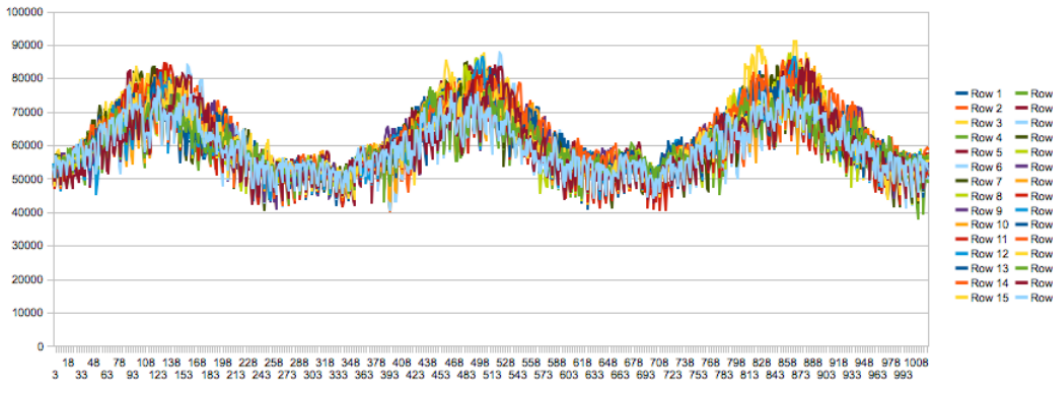
Figure 1. Demand profiles for the 30 stochastic scenarios of instance